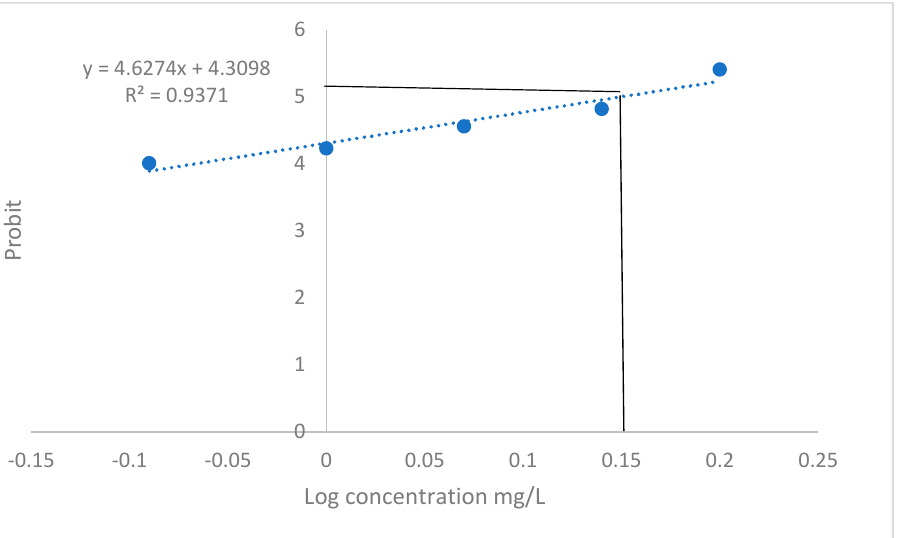
y = 4.6274x + 4.3098